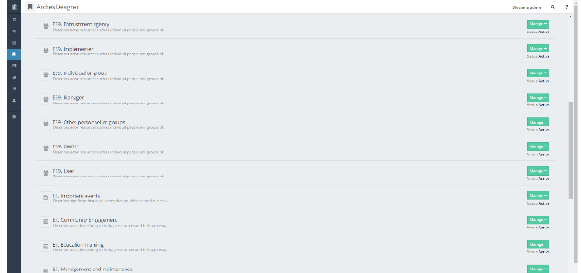
Figure 9. Display chart of home page connection function